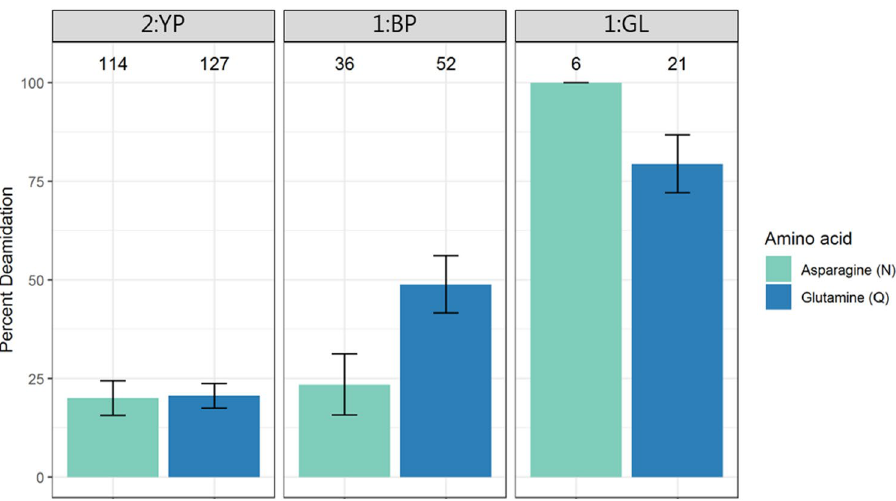
Figure 2. Percentage of deamidation of asparagine (N) and glutamine (Q) residues in the three analysed samples. Error bars indicate standard deviation around 1000 bootstrap replicates. Sample identifiers are shown at the very top, while the number of peptides used for the calculation is indicated above each bar.